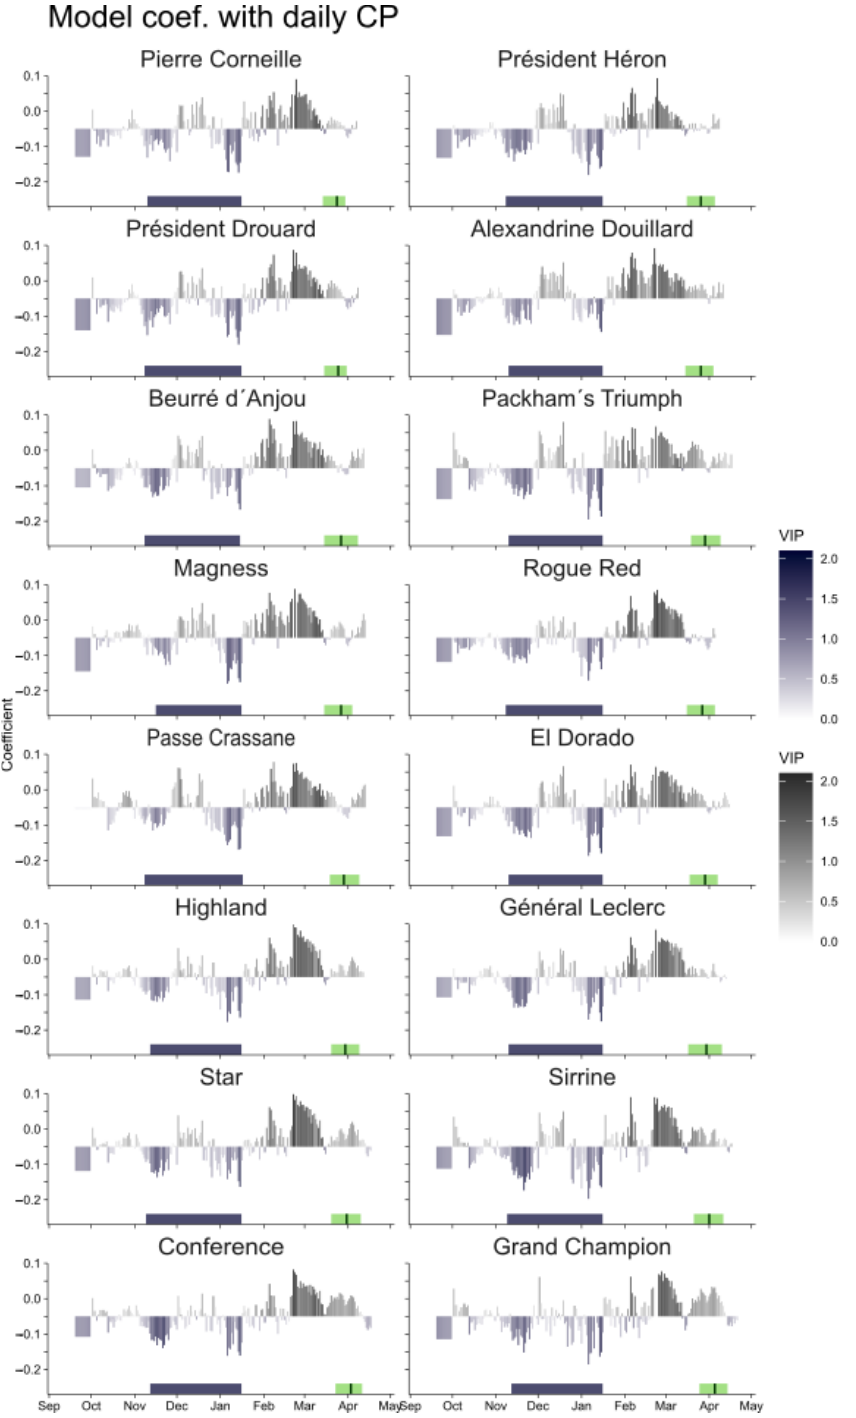
Figure 2. Partial Least Squares regression analysis between flowering dates of 16 cultivars of pear grown in Zaragoza (northeastern Spain) and daily accumulations of winter chill in Chill Portions (CP) according to the Dynamic model. The direction of the vertical bars in each plot indicates days with positive or negative model coefficients, and the color of the bar represents the variable importance in the projection (VIP) score (with blue for negative coefficients and gray for positive coefficients). Horizontal thick bars at the bottom of each plot indicate the delineated chilling (blue) and the range of observed flowering dates (green). In the bars showing the flowering range, the dark purple vertical line indicates the median flowering date in the 20 years analyzed.